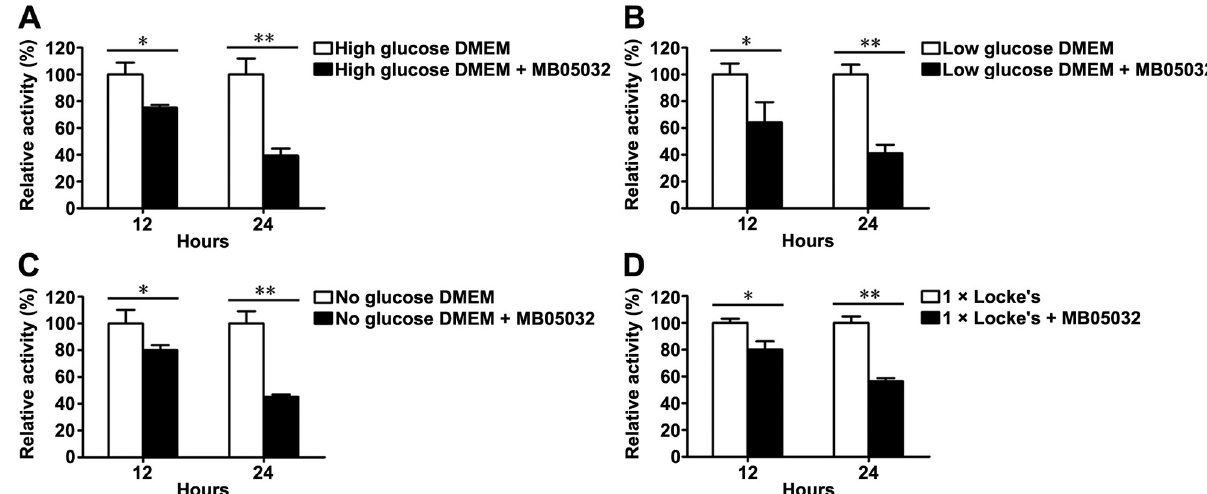
Fig 5. Native Cs FBPase activity inside C . sinensis adults with or without MB05032 treatment. Adult flukes were respectively maintained on high, low, and no glucose DMEM (A, B, and C), as well as 1 × Locke’s (D) with or without the addition of MB05032. Native Cs FBPase activity was measured at 12 and 24 h of feeding. Differences between two groups were evaluated by student’s t test. � P < 0.05 and �� P < 0.01 were represented as statistical